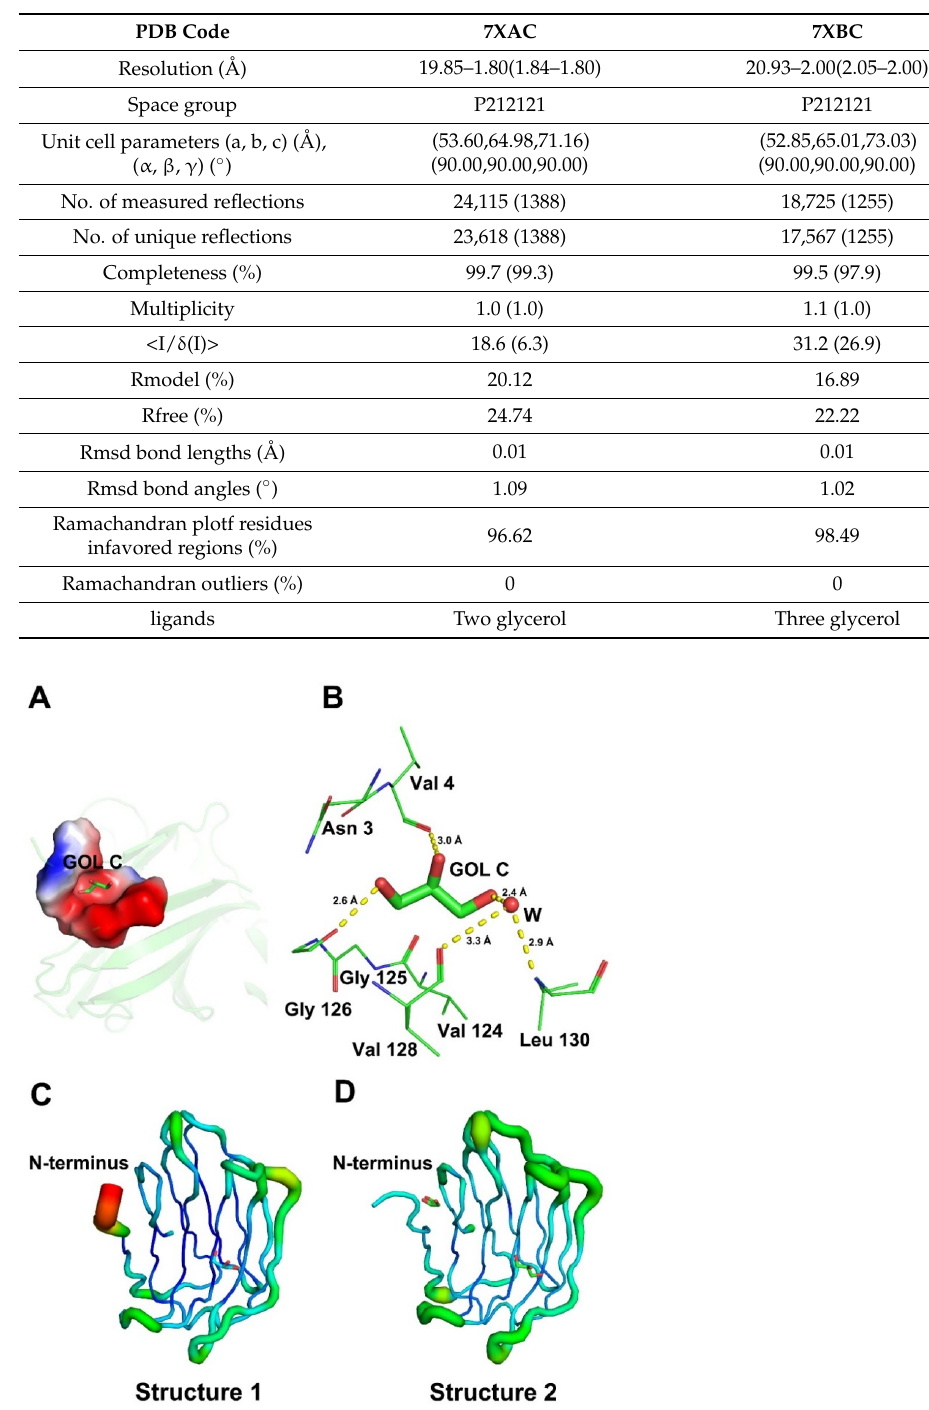
Table 1. Data collection and refinement statistics.